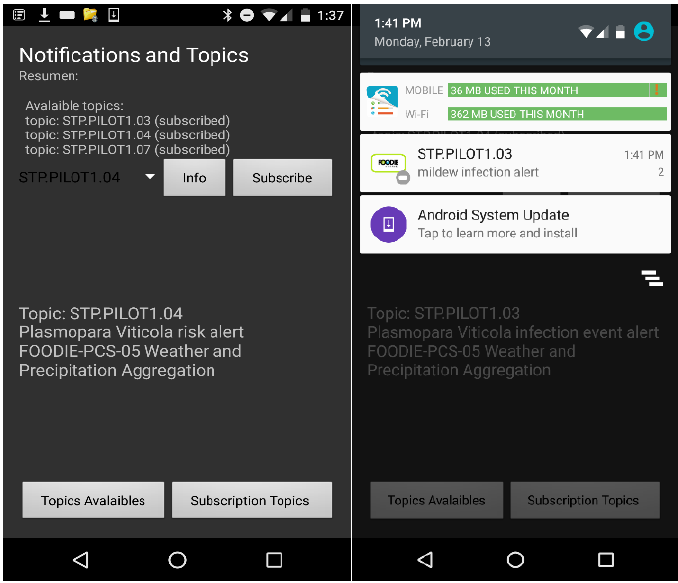
Figure 2. User interface of the developed alerting service: a notification received on a smartphone ( the left image ) and the content of a notification in a structure customized in advance by a user ( the right image ).